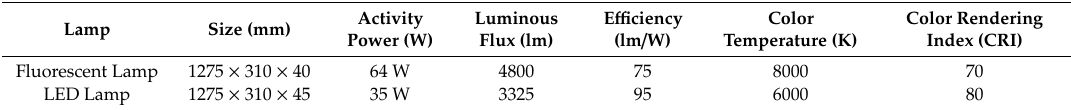
Table 2. Characteristics of fluorescent lamps and LED lighting [35].